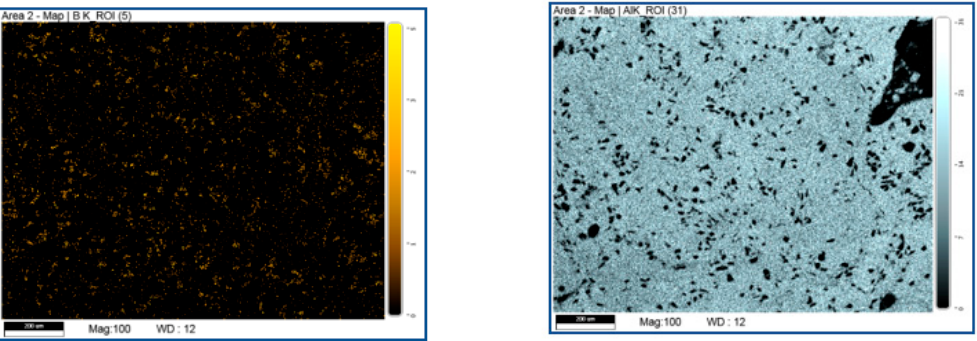
Figure 7. EDX mapping test of boron (left) and Al (right). Boron is well distributed in the Al structure.